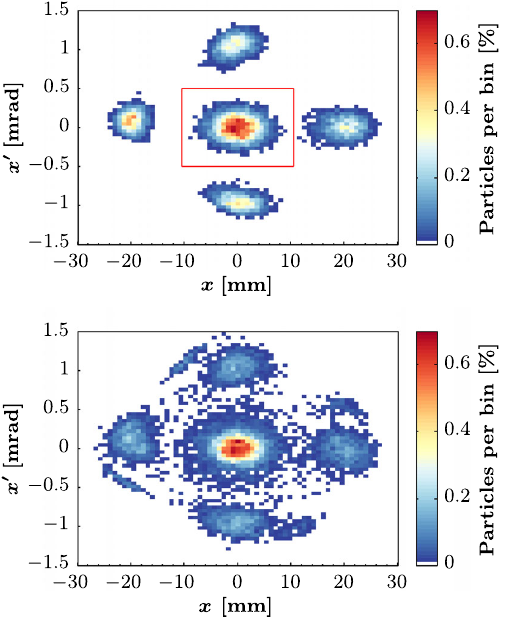
FIG. 10. WS54 measurements of the evolution of the transverse splitting along the cycle, with the simulated positions of the core (circle) and the islands indicated by the respective markers. In this case, the resonance was crossed at 760 ms and the rotation of the phase space started around 808 ms (indicated by the white solid line). Note the apparent discontinuity in the islands ’ positions at this moment, which is due to the projection effect from phase space to horizontal space.